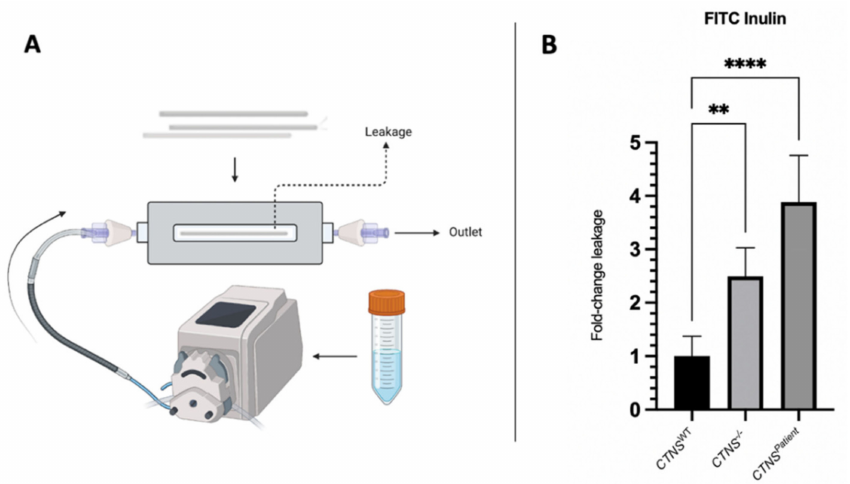
Figure 4. FITC inulin leakage assay in kidney. ( A ) Graphical presentation of the experimental set-up for the assessment of the monolayer leakage. The kidney tubules were secured into a 3-D printed chamber and connected to a pump with an in-let and out-let needle. Fluorescent FITC-inulin solution was perfused through the inside of the fiber and after 10 min, the solution that leaked through the kidney tubules to the extraluminal compartment was collected and measured. ( B ) Leakage of the healthy and cystinotic kidney tubules is expressed in fold change compared to the healthy control and normalized to a double-coated but unseeded HFM. One-way ANOVA statistical analysis was performed (N = 3; ** p -value < 0.01; **** p -value <